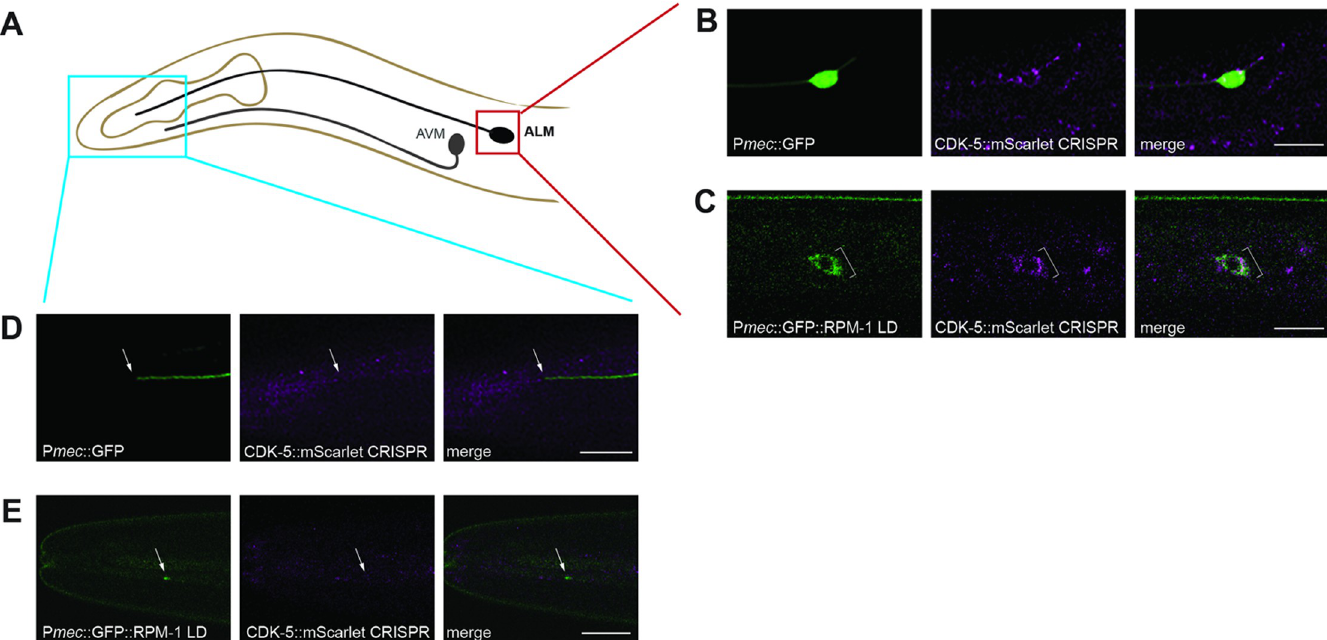
Fig 6. CDK-5 colocalizes with RPM-1 LD in neuronal soma. A ) Schematic showing ALM mechanosensory neuron and region imaged for axon termination site (blue) and soma (red). B ) CDK-5::mScarlet CRISPR is present in the soma of ALM neurons (bracket) visualized using transgenic GFP expressed in mechanosensory neurons ( muIs32 ). C) CDK-5::mScarlet colocalizes with GFP::RPM-1 LD in ALM soma (bracket). D) Representative images showing CDK-5::mScarlet is not detected at the ALM axon tip visualized using transgenic GFP (arrow). E) GFP::RPM-1 LD accumulates at the ALM axon tip (arrow) where CDK-5::mScarlet is not detected. Scale bars 10 μ